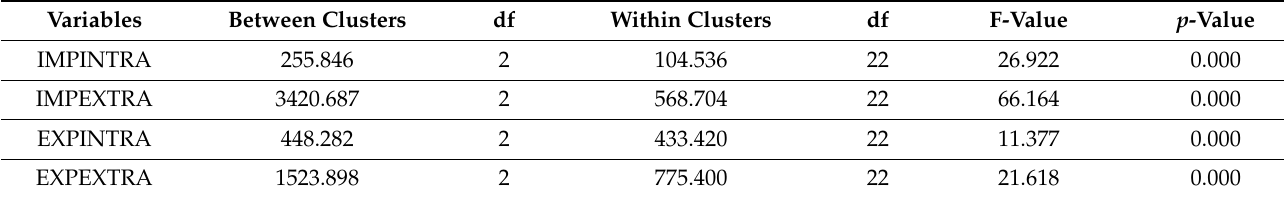
Table 2. Between and within cluster variance in cluster analysis for year 2018.